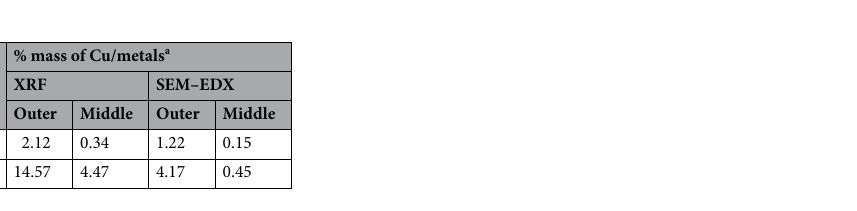
Table 2. Elemental mappings of XRF and SEM-EDX. a % mass of Cu/metals = amount of Cu × 100/(amount of metal-free